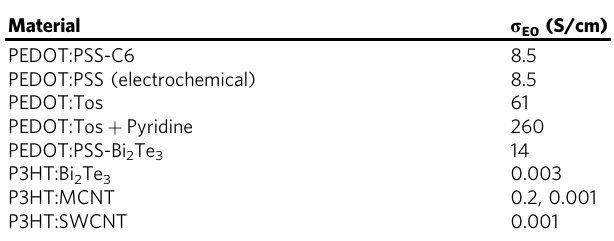
Table 4 Transport parameter for PEDOT and P3HT